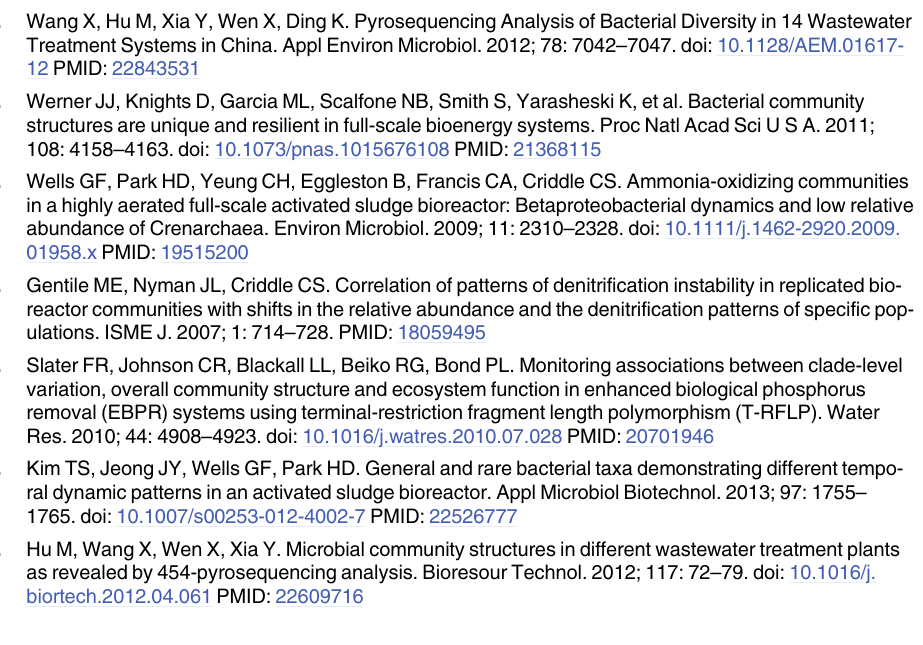
S3 Table. Different α -diversity indices of 33 samples. S4 Table. Abundance of genera across the 33 samples. S5 Table. Bray-Curtis similarity coefficients of microbial communities. S6 Table. Robust tested by changing the training dataset and validation dataset. S7 Table. The taxonomy assignment of the